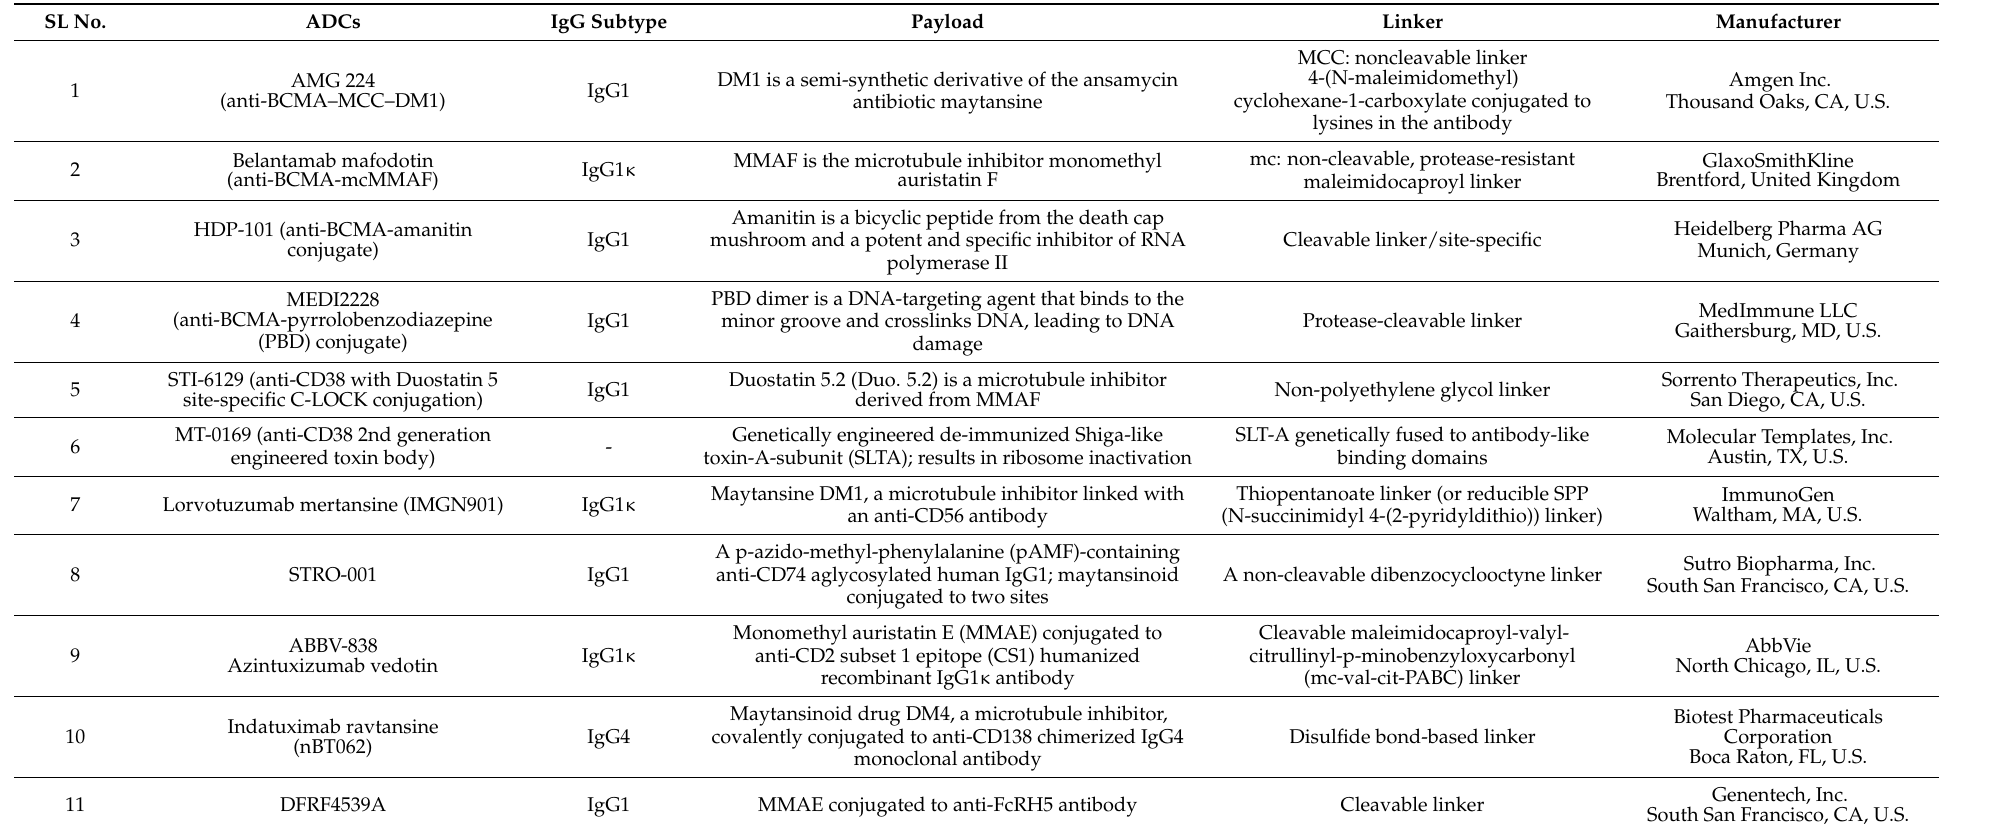
Table 1. Antibody–Drug Conjugates in Clinical Trials in Multiple